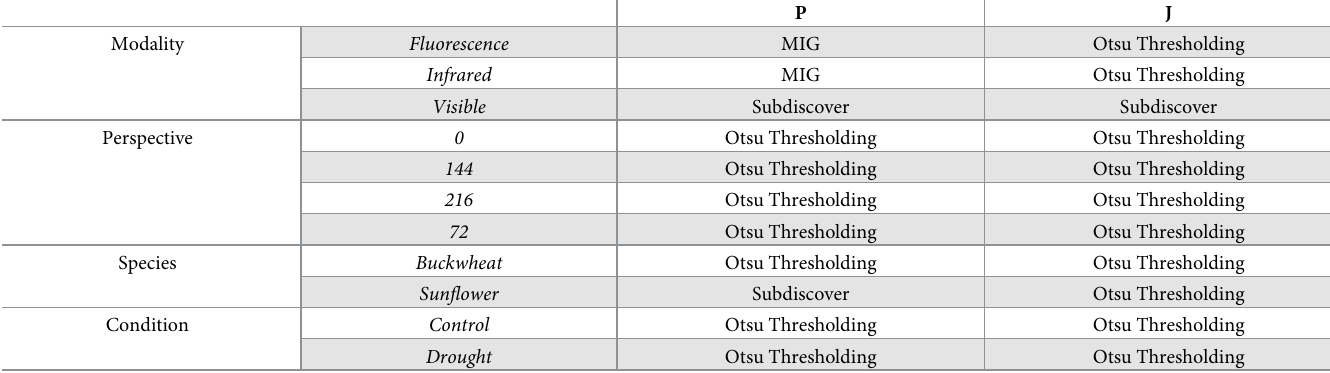
Table 8. Summary of the algorithms with the highest Precision and Jaccard for each feature in CosegPP